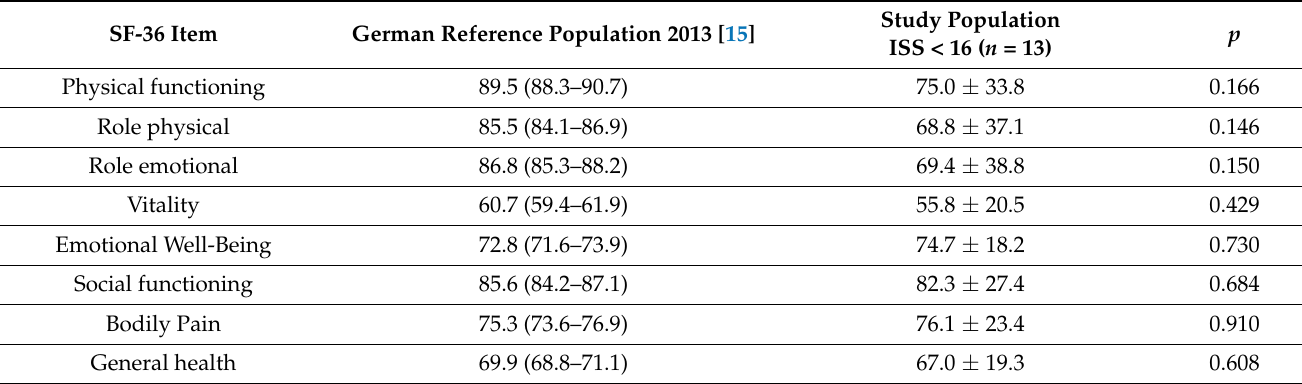
Table 2. The eight main SF-36 items results of a population with ISS < 16 in comparison to the normative data of the German population